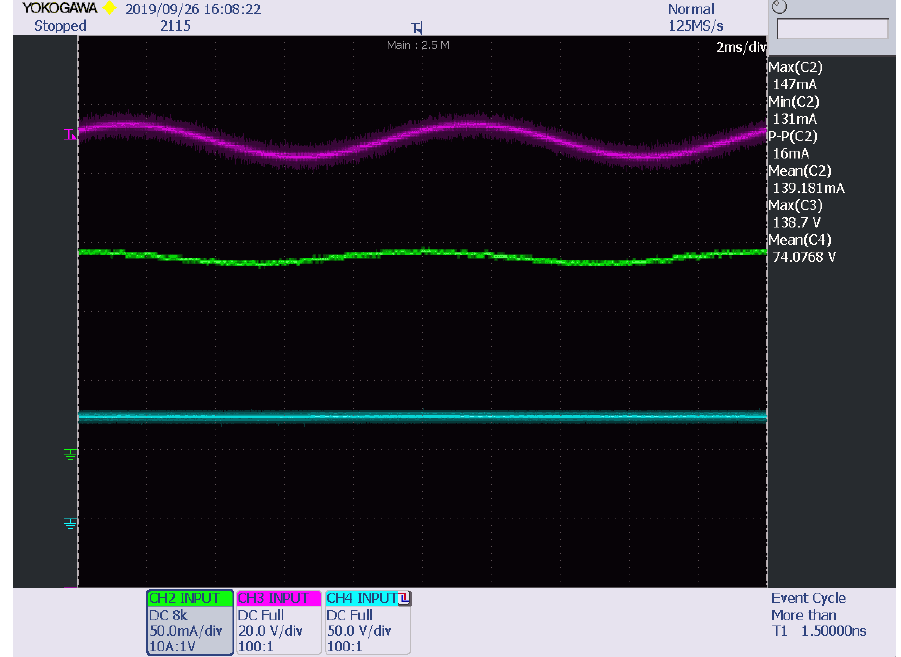
Figure 21. Experimental waveforms at i LED = 0.14 A with PI controller enabled. (5,7% ripple). Channel 2: LED current, green trace, 50 mA/div; Channel 3: Bus voltage, magenta trace, 20 V/div; Channel 4: LED voltage, cyan trace, 50 V/div.